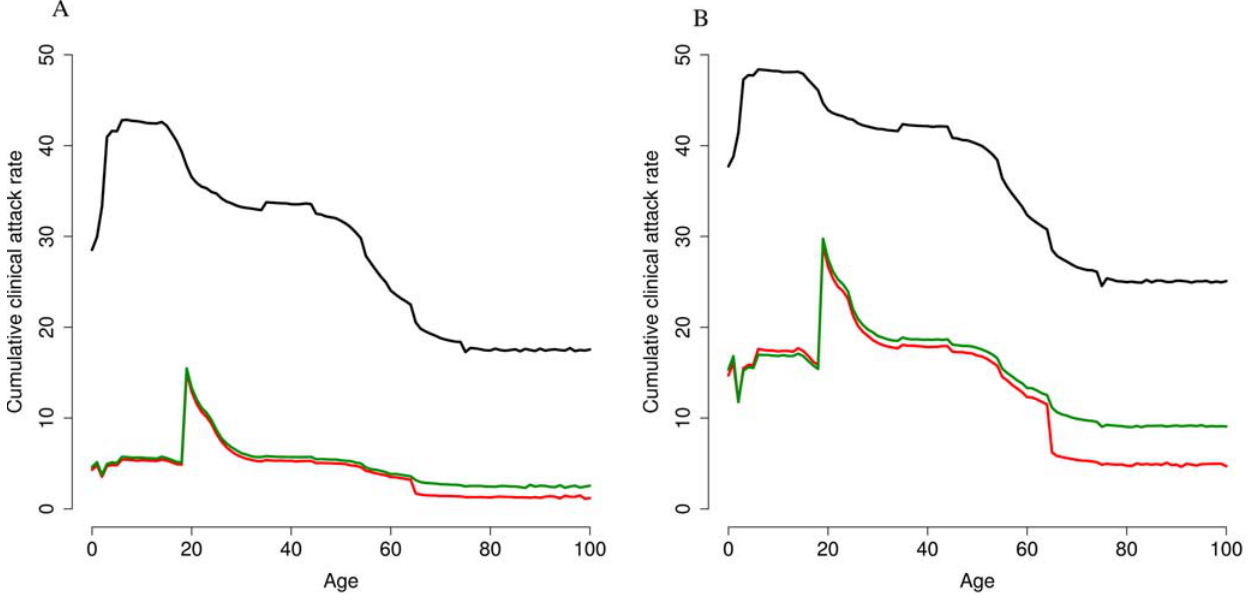
Figure 4. Cumulative clinical AR, by age and scenario (Panel A: R 0 =1.7; Panel B: R 0 =2). Black line represents baseline results; red line represents the standard vaccination strategy (i.e., personnel providing essential services; elderly persons; and 2–18 year-olds); green line represents the effect of limiting vaccination to essential workers and children. Table S5 Age class of singles without children. Found at: doi:10.1371/journal.pone.0001790.s006 (0.01 MB PDF) Figure S1 Found at: doi:10.1371/journal.pone.0001790.s007 (0.30 MB TIF) Figure S2 Found at: doi:10.1371/journal.pone.0001790.s008 (1.56 MB TIF) Figure S3 Found at: doi:10.1371/journal.pone.0001790.s009 (1.05 MB TIF) Figure S4 Found at: doi:10.1371/journal.pone.0001790.s010 (0.38 MB TIF) Figure S5 Found at: doi:10.1371/journal.pone.0001790.s011 (0.98 MB TIF) Figure S6 Found at: doi:10.1371/journal.pone.0001790.s012 (0.51 MB TIF) Figure S7 Found at: doi:10.1371/journal.pone.0001790.s013 (0.62 MB TIF)